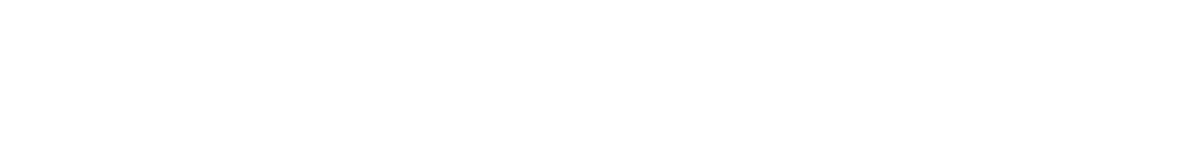
Frontiers in Genetics |